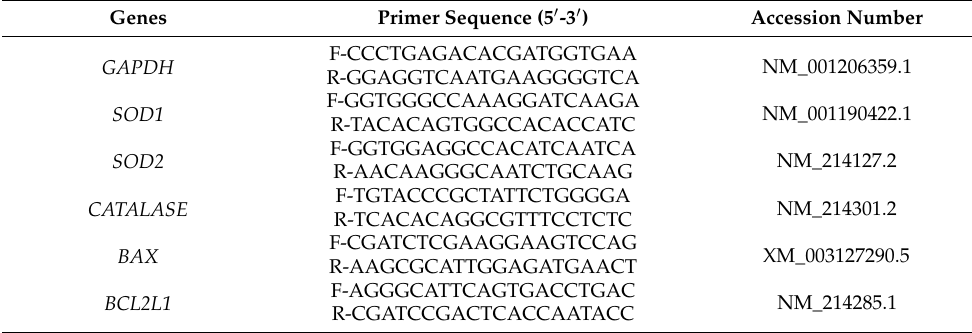
Table 1. PCR sequences used for real-time quantitative PCR (qPCR).